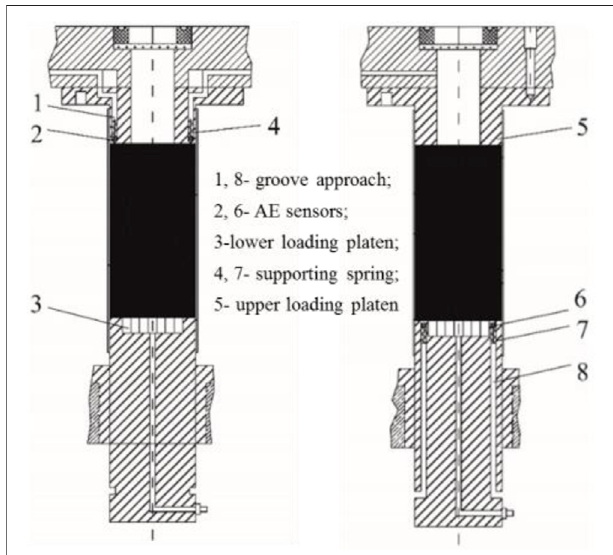
FIGURE 3 | Structure diagram for the installation of acoustic emission